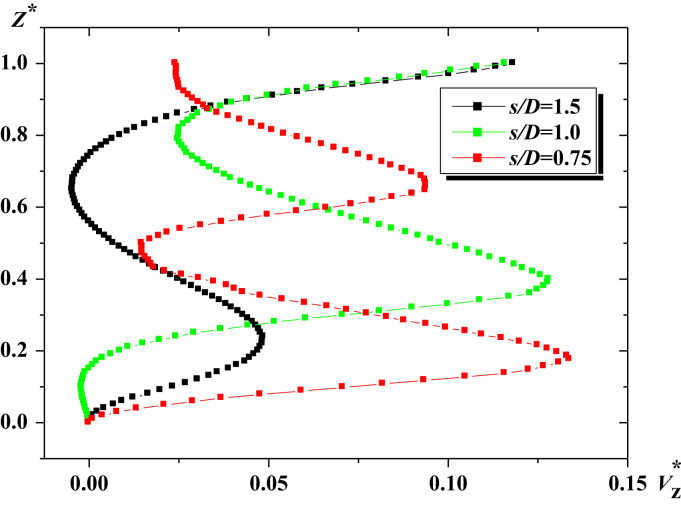
Axial velocity for the Natrosol liquid, Reg=10, R*=2R/D=0.5.